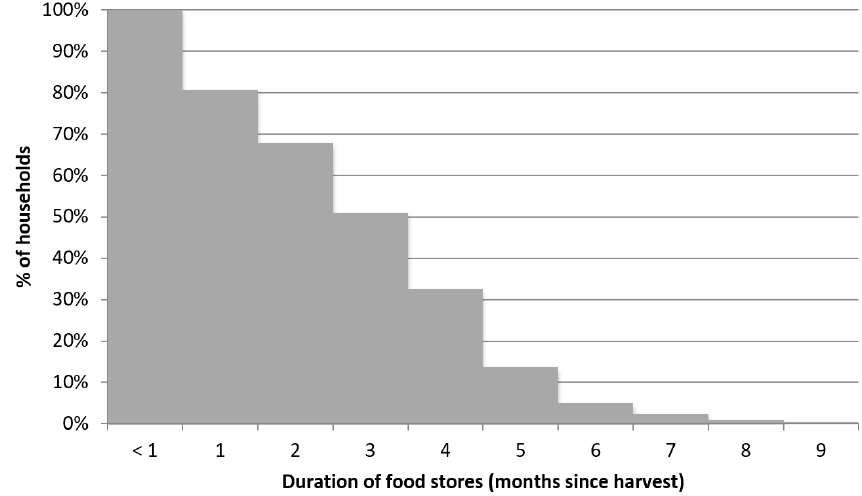
Figure 3. Distribution of the duration of household food stores.